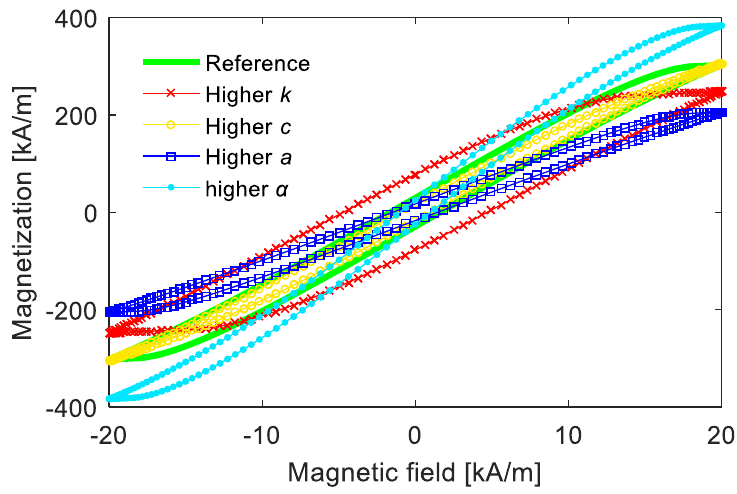
Figure 2. Examples of magnetic hysteresis computed from Jiles – Atherton model.